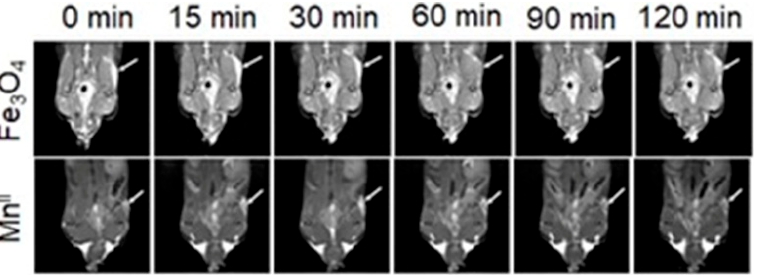
Figure 63. T 1 - and T 2 -weighted MRI of tumor-bearing mice acquired pre- and post-injection of Mn II and Fe 3 O 4 samples. The tumor is marked by white arrows. Adapted from Biomaterials , 194 , Sun, X.; Zhang, G.; Du, R.; Xu, R.; Zhu, D.; Qian, J.; Bai, G.; Yang, C.; Zhang, Z.; Zhang, X.; Zou, D.; Wu, Z. A